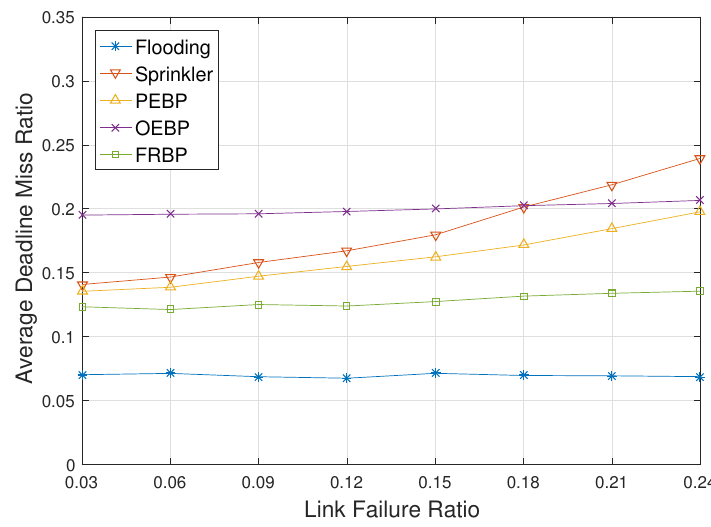
Figure 10. Deadline missed ratio impacted by the link failure ratio.